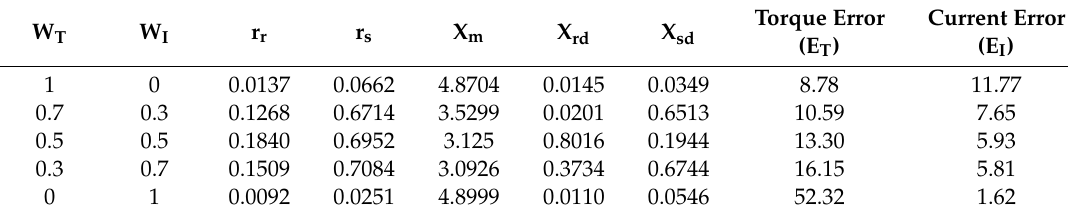
Table 2. Weights of the objective functions (W T and W I ), parameters obtained in p.u., and resulting errors of torque (E T ) and current (E I